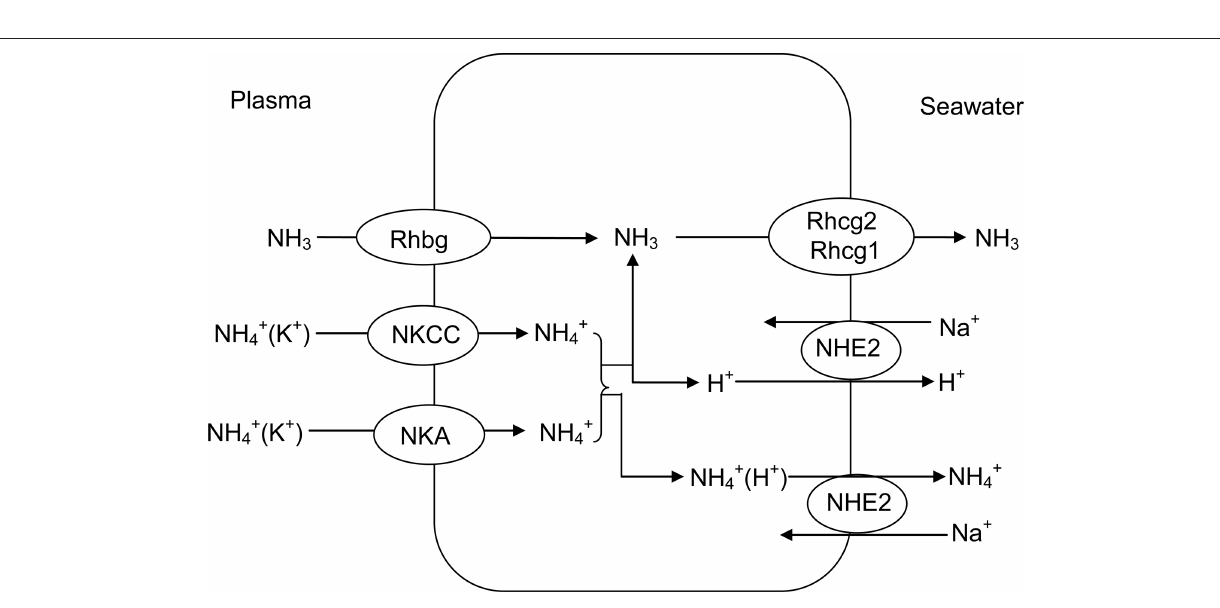
Figure 5 | The roles of rhesus glycoproteins (rhbg, rhcg1, and rhcg2), in conjunction with those of Na + /K + -ATPase (NKA), Na + :K + :2Cl − -cotransporter (NKCC), and Na + /H + exchanger 2 (NHe2), in ammonia excretion through the gills of marine